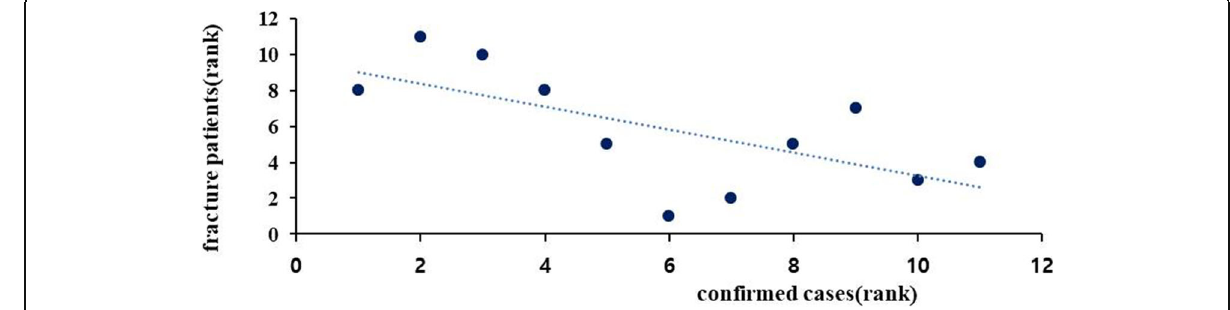
Fig. 1 Correlation between COVID-19 confirmed cases and oral and maxillofacial fracture patients during 2020 ( r = − 0.667, P =